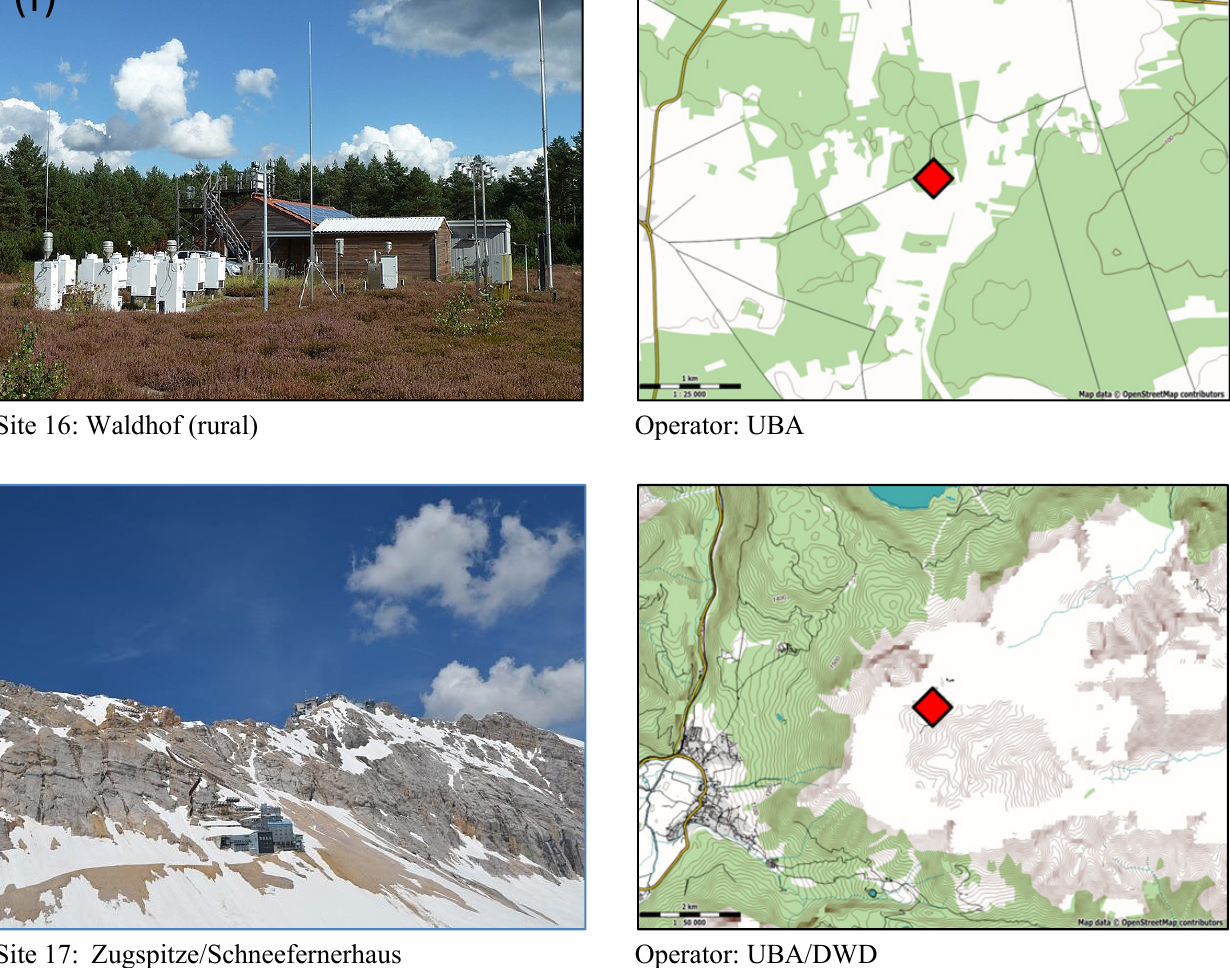
Figure 2. Illustration of the GUAN measurement sites: (a) sites 1–3, (b) sites 4–6, (c) sites 7–9, (d) sites 10–12, (e) sites 13–15, (e) sites 16–17. Pictures illustrate the surroundings of each station. The maps show the geographic area, illustrating major types of land use (Source: OpenStreetMap, processed by Maperitive V.2.3.22). The location of each measurement site is marked by a